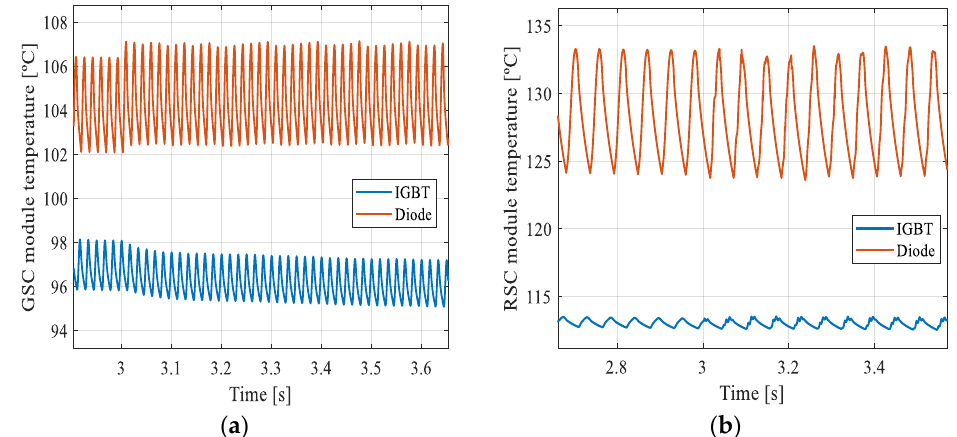
Figure 22. Junction temperature of the power module during an unbalanced voltage sag of 70%: ( a ) GSC and ( b ) RSC.